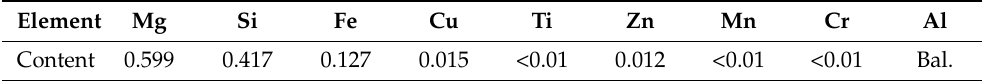
Table 1. Chemical composition of 6063 alloy (Mass fraction, %).